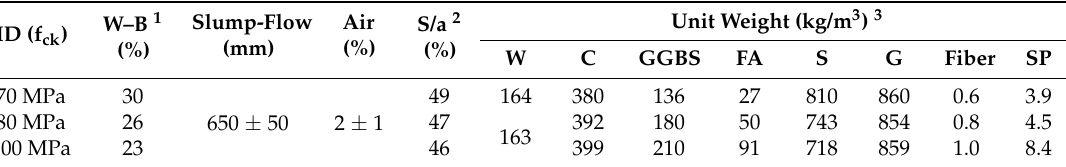
Table 2. Concrete mix